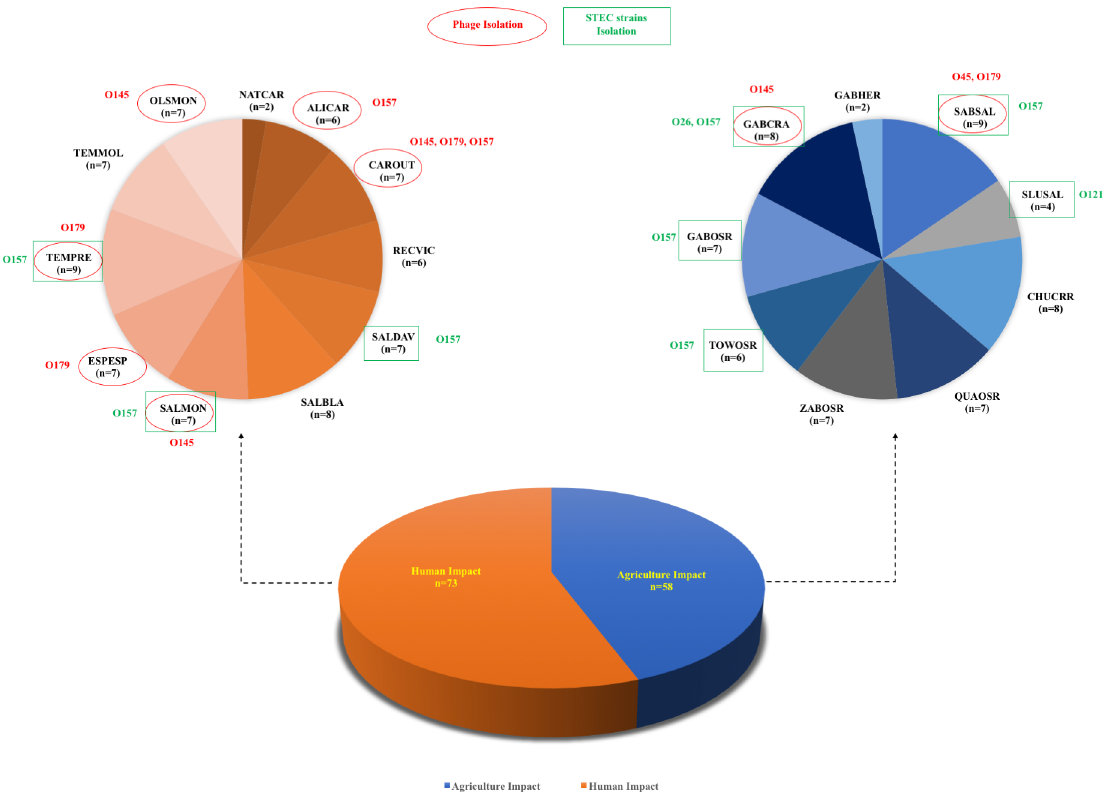
Fig 2. Summary of phage and STEC isolation data from water samples collected from Salinas, CA. The acronym is used for each sample site with the number of water samples collected.Red oval shapewith red letter indicatesisolationof STEC- specific phage,and green rectangularshapewith green letters indicatesSTEC bacterial